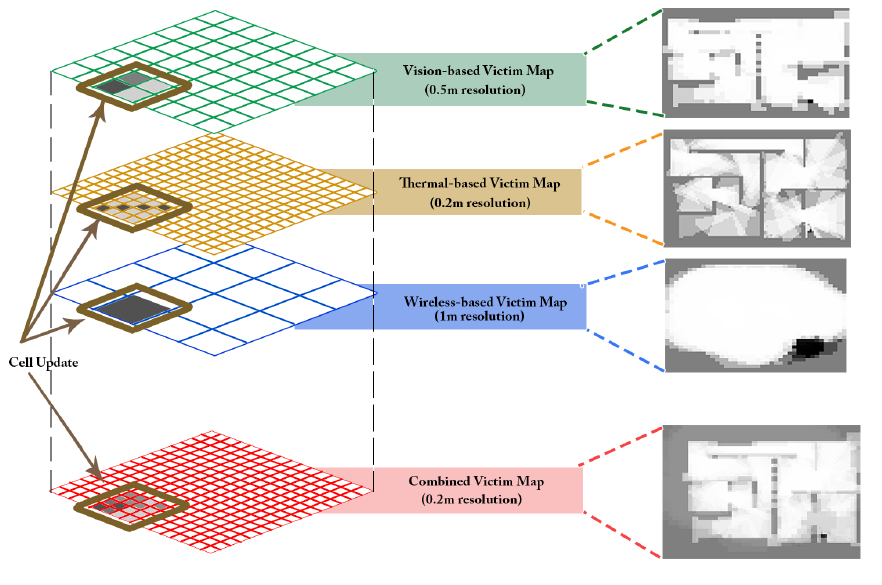
Figure 8. Merged map obtained from three maps of different resolutions where a single cell update is